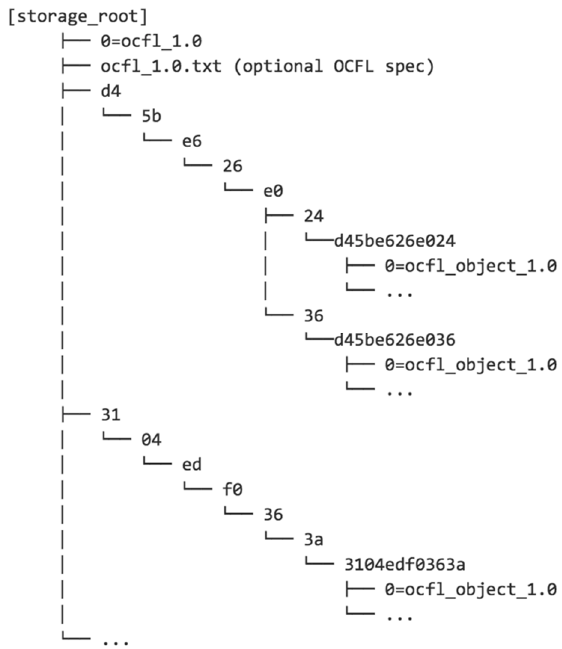
Figure 2. An example of a Pairtree OCFL Storage